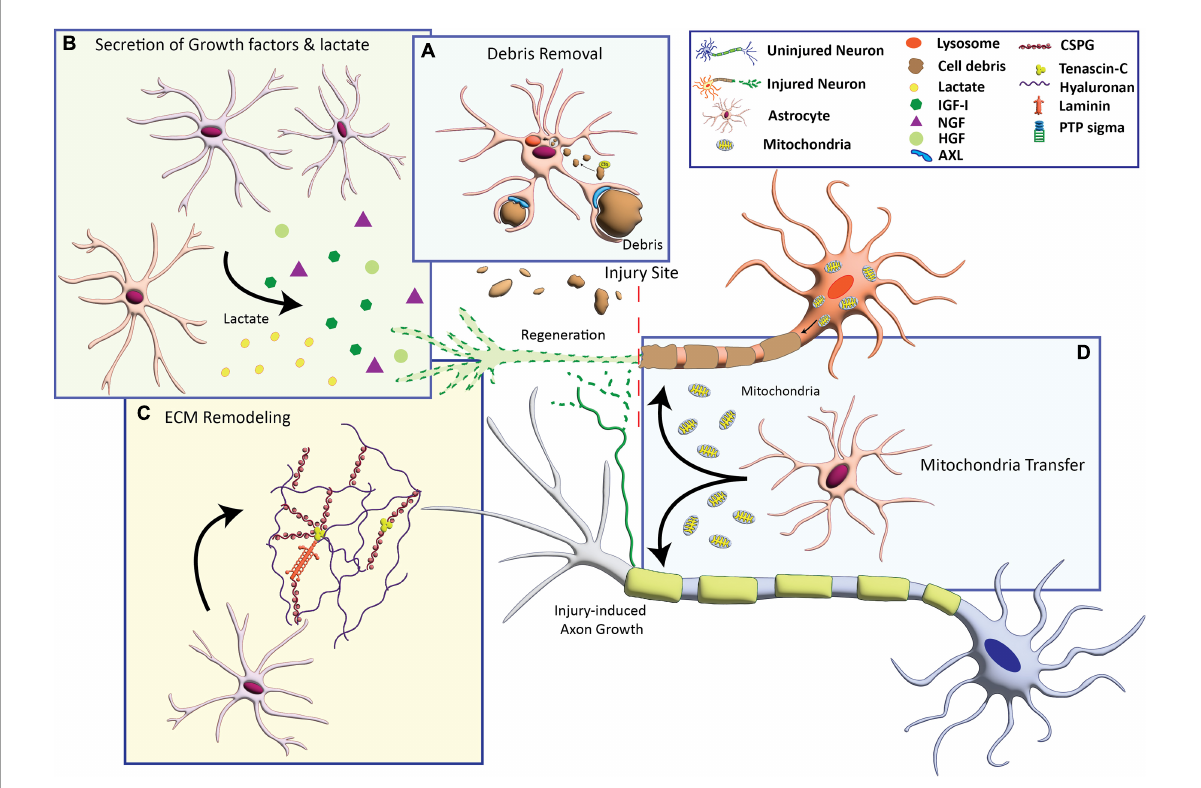
FIGURE1 Astrocyte-based mechanisms that can promote axon growth. (A) Activation of phagocytosis to engulf cellular debris that inhibit axon growth. (B) Secretion of growth factors including insulin-like growth factor (IGF-I), nerve growth factor (NGF), and hepatocyte growth factor (HFG), and the metabolite lactate. (C) Production of extracellular matrix (ECM) molecules including laminin and axon growth-permissive chondroitin sulfate proteoglycans (CSPGs). (D) Transfer of healthy mitochondria to compromised neurons to provide bioenergetic support for axon growth.